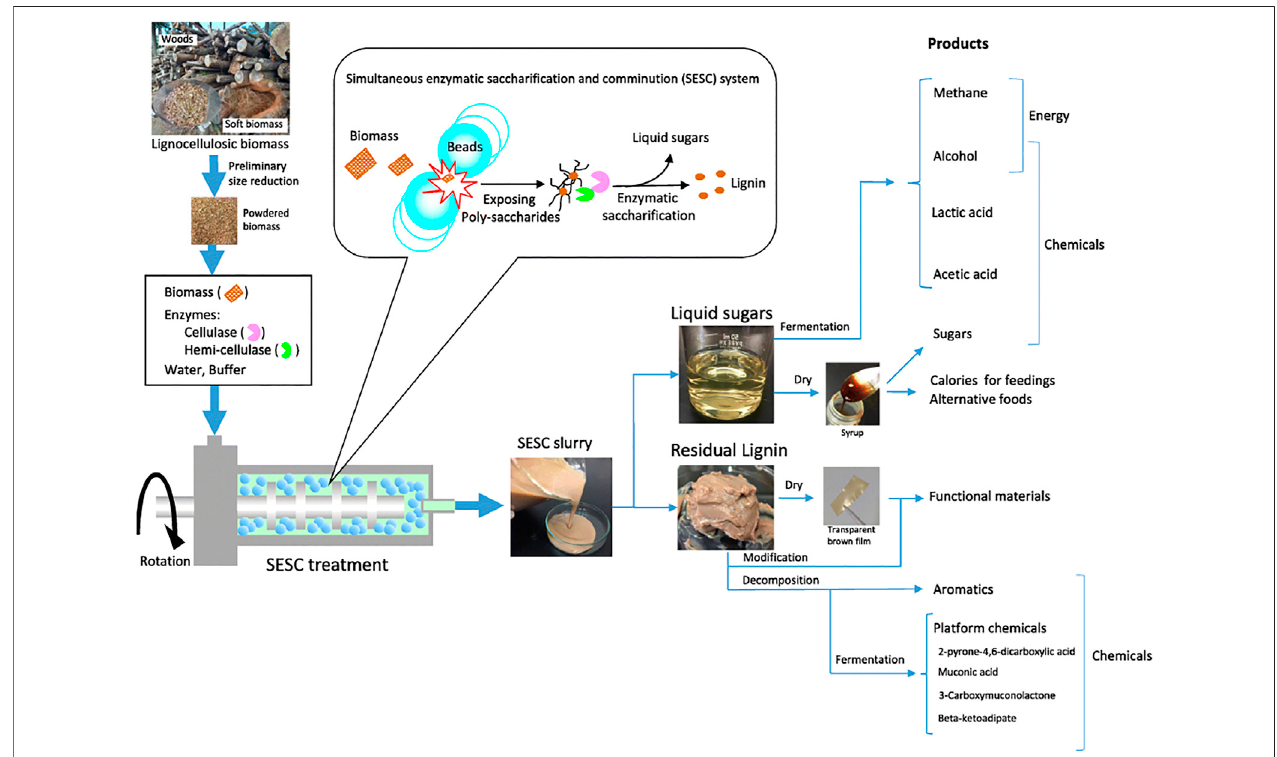
FIGURE 7 | Valorization of lignocellulosic biomass by the SESC process (Navarro et al., 2018).